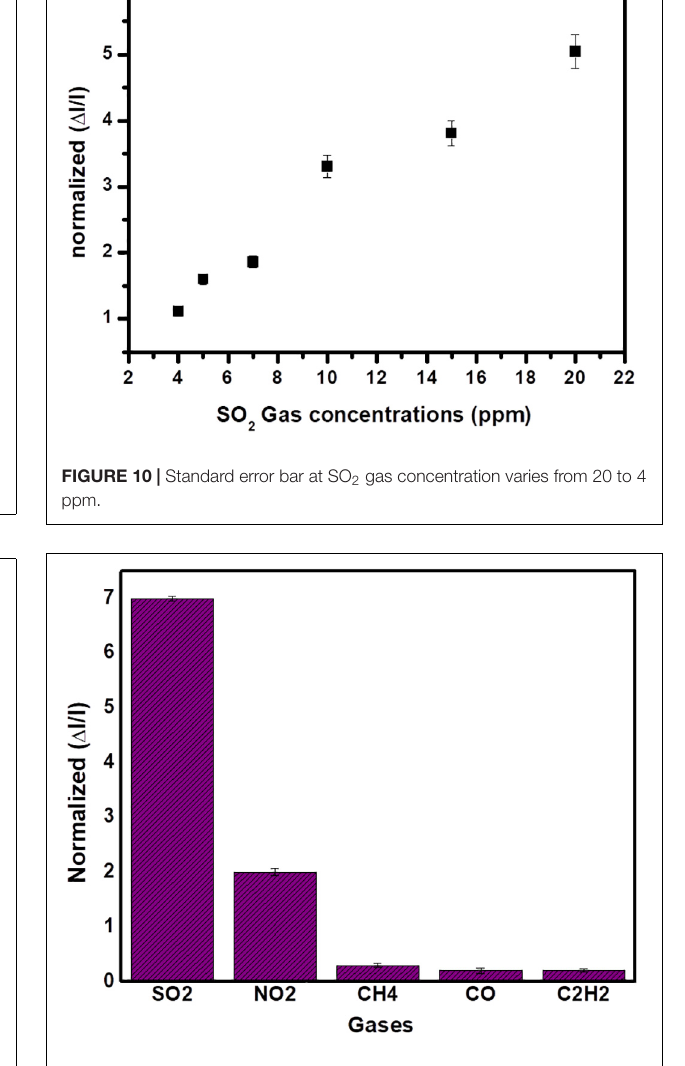
FIGURE 9 | At 15 ppm SO 2 gas concentration, response and recovery time with baseline.